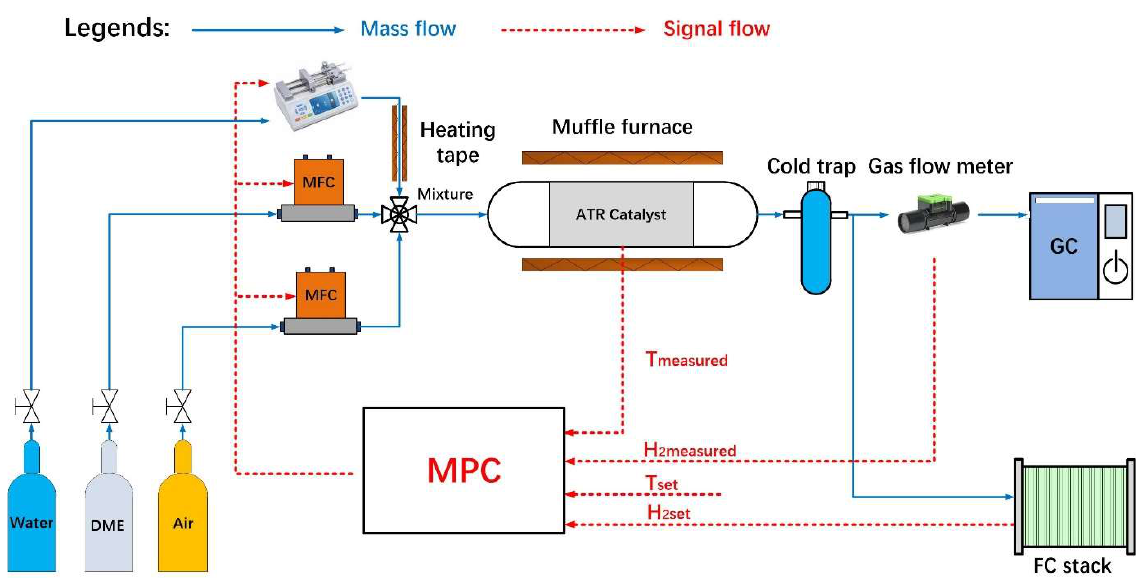
Figure 3. Schematic diagram of the controlled pilot plant unit for the hydrogen production system.